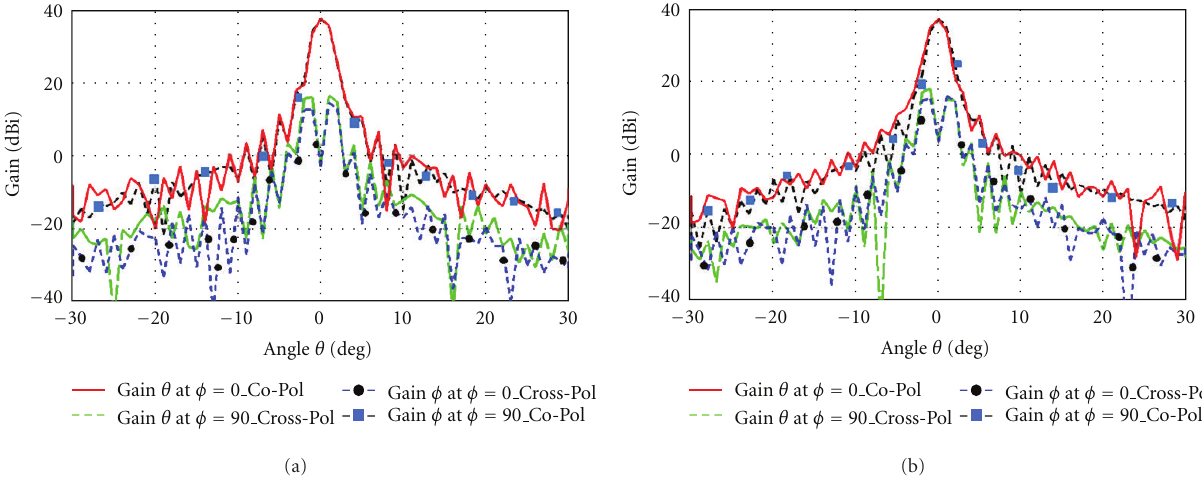
Figure 16: Reflector antenna radiation patterns at 7.73GHz with the feedhorn mode combination of TE 11 (40%) + TM 01 (30%) + TE 21 (30%) for (a) +90 ◦ and (b) − 90 ◦ phase